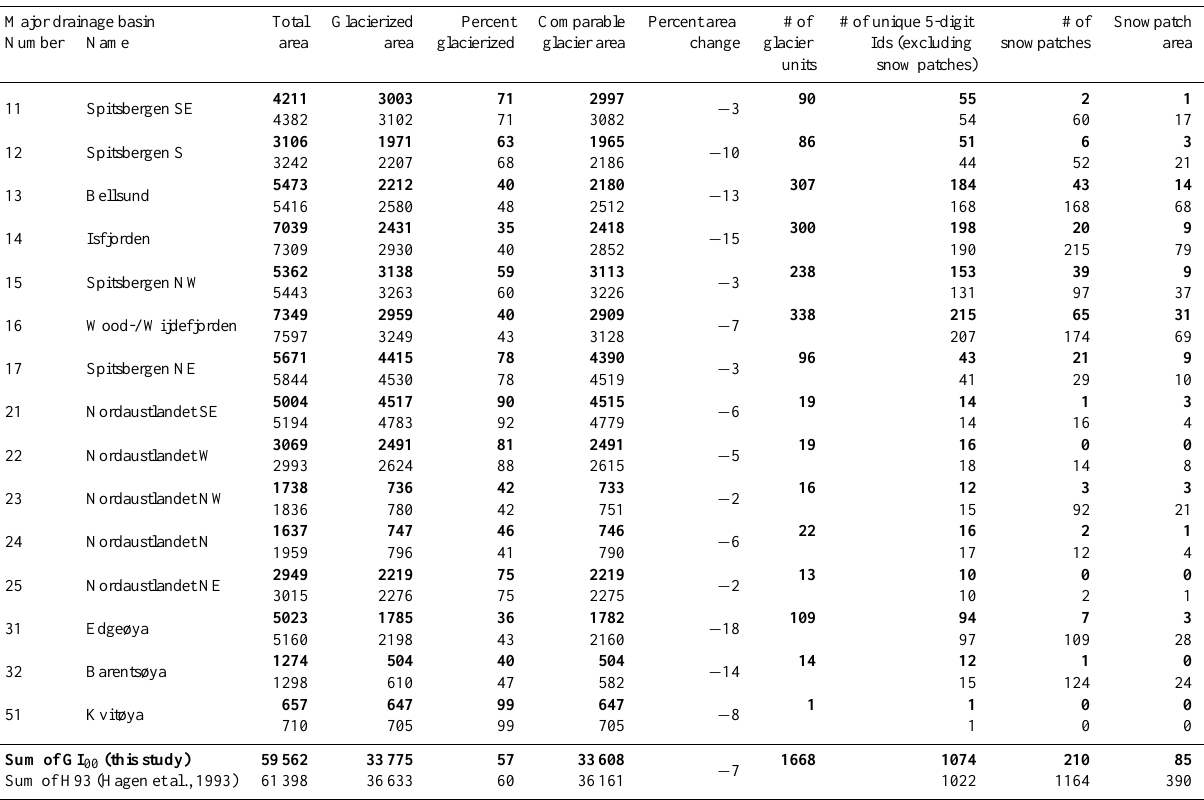
Table 2. Glacier statistics for the major drainage basins of Svalbard for H93 and GI 00s (in bold ). Total area is the size of the drainage basin, both glacier and land. “Glacierized area” is the total glacierized area in each atlas. Differences in this parameter include glacier change and ommission/commission errors between the datasets. “Comparable glacier area” is the area corresponding to similar IDs in both inventories excluding snow patches and glacierets (see Sect. 3.2). Differences in this parameter include glacier changes and an error associated with delineating glaciers. “Percent area change” is derived from “omparable glacier area”. The number of glacier units is provided only for GI 00s as the number of unique 5-digit IDs (no decimals) provides the total number for H93. For GI 00s , this is the number of merged integer IDs. Also shown is the number of individual snow patches (GI 00s IDs = XXX99.XX) and glaciers less than 1km 2 (H93) along with the area sums. All area estimates have unit km 2